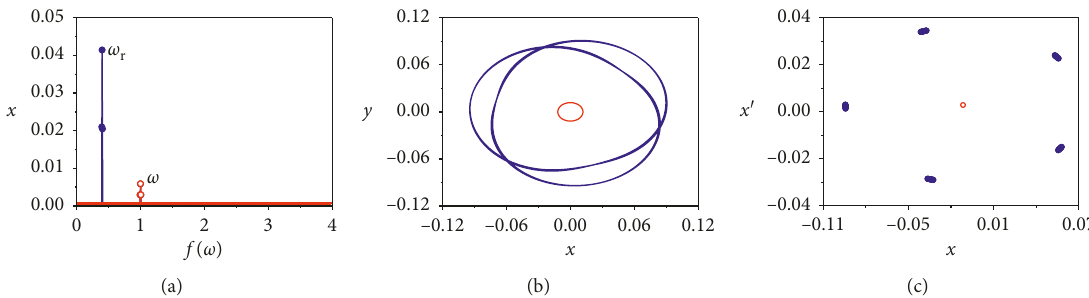
Figure 8: The response of the rotor/seal system at s � 2.5. (a) The frequency spectrum of the x coordinate. (b) The orbit of the rotor. (c) The Poincar´e map of the x